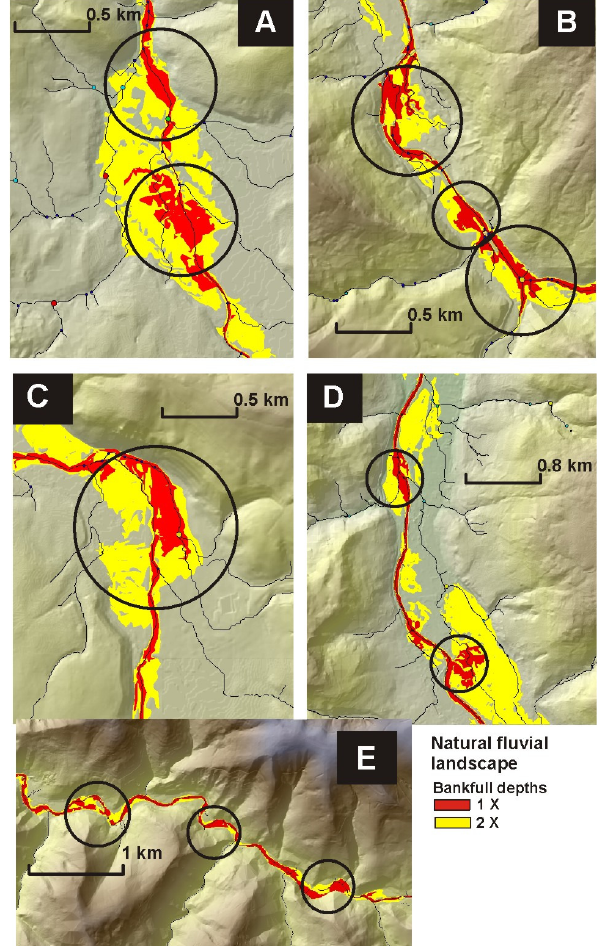
Fig. 11. A sample of close up images is shown of the predicted flu- vial landscape at potential restoration areas: (A) an enlarged fluvial landscape located at the transition from an unconfined to a confined valley in combination with a large tributary confluence (N in Figs. 4 and 8, #6 in Fig. 10); (B) individual fluvial landscapes that have high potential for lateral connectivity are located at the site of a large me- ander and at a significant tributary confluence (F, G, Figs. 3 and 4, #3 and 4 in Fig. 10); (C) an area within the East Fork basin where a channel interacting with hillslope creates a large meander, in com- bination with a high density of parallel running tributaries, could denote a potentially productive and complex fluvial landscape (#5 in Fig. 10); (D) areas within the wide valley of the West Fork, one of which may be influenced by a confluence (E, Figs. 3 and 4); and (E) the upper West Fork segment where hillslope/fan forcing has created alternating wide and narrow fluvial landscapes (H in Fig. 4, #1 in Fig.